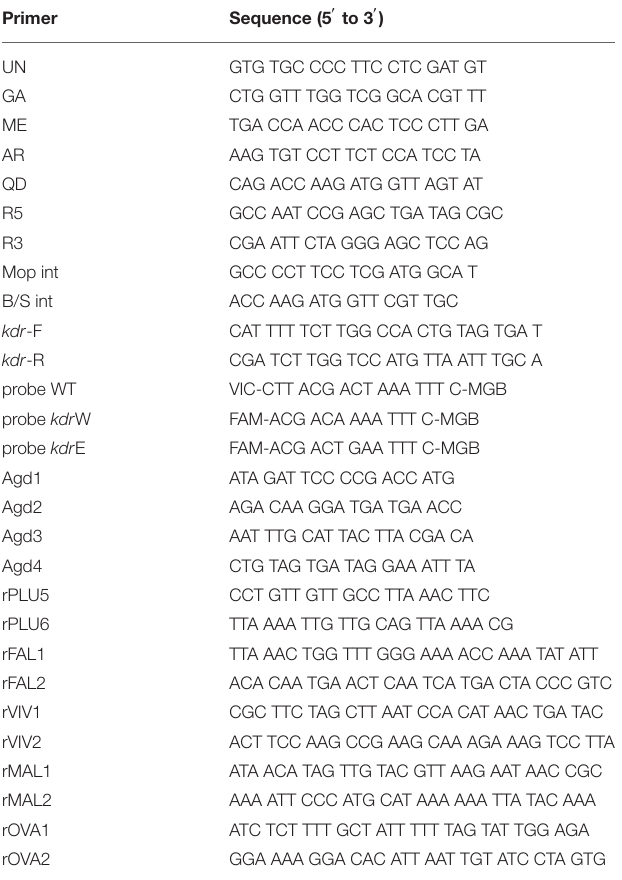
TABLE 2 | Sequences of the primers used throughout this